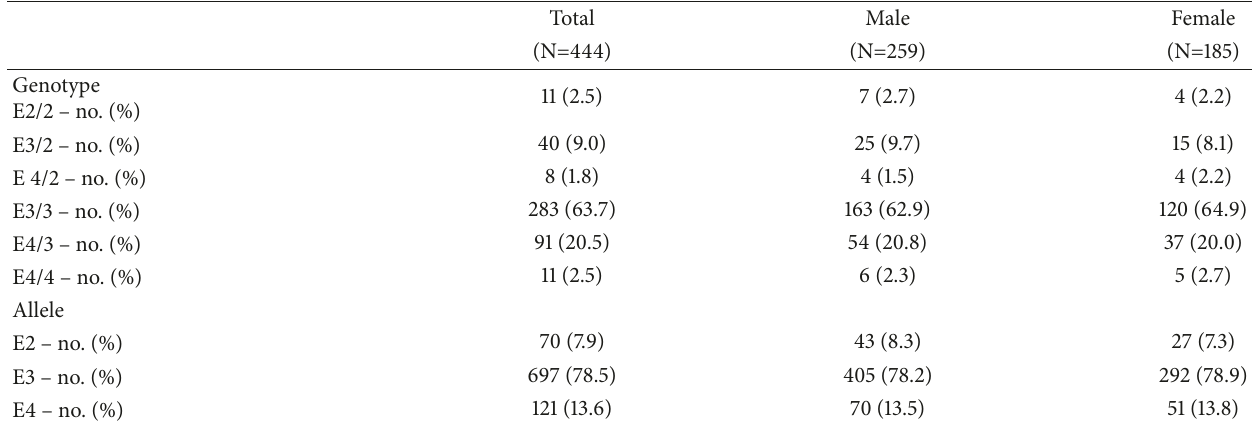
Figure 1: Lipid profile by APOE genotype. APOE: apolipoprotein E; LDL: low-density lipoprotein; Apo: apolipoprotein. Table 1: Frequency of APOE genotype and APOE allele by